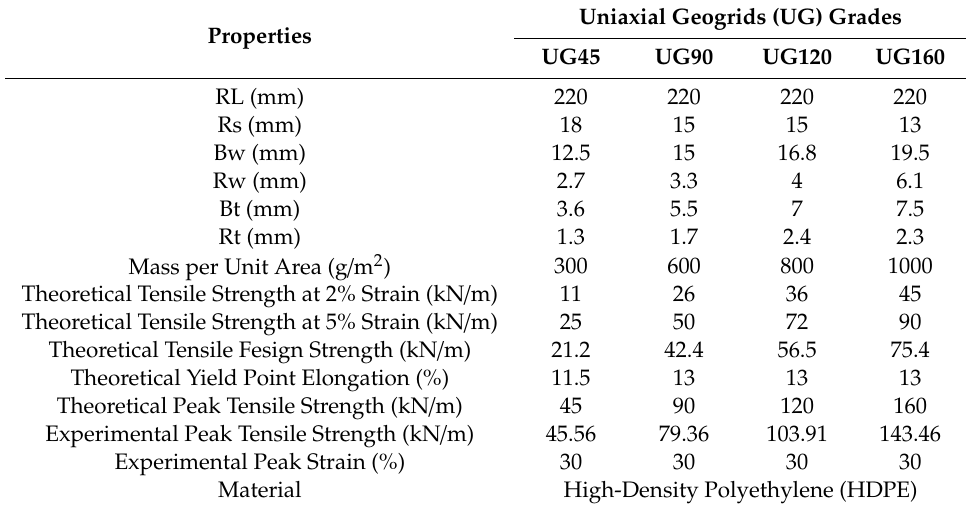
Table 3. Properties of the uniaxial geogrids by the manufacturer and experimental tests. Properties